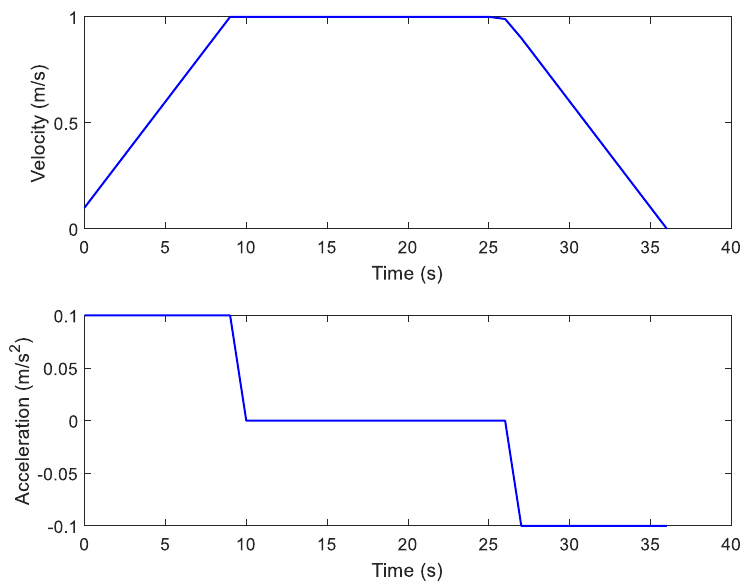
Figure 6. Motor’s input current with respect to the velocity.